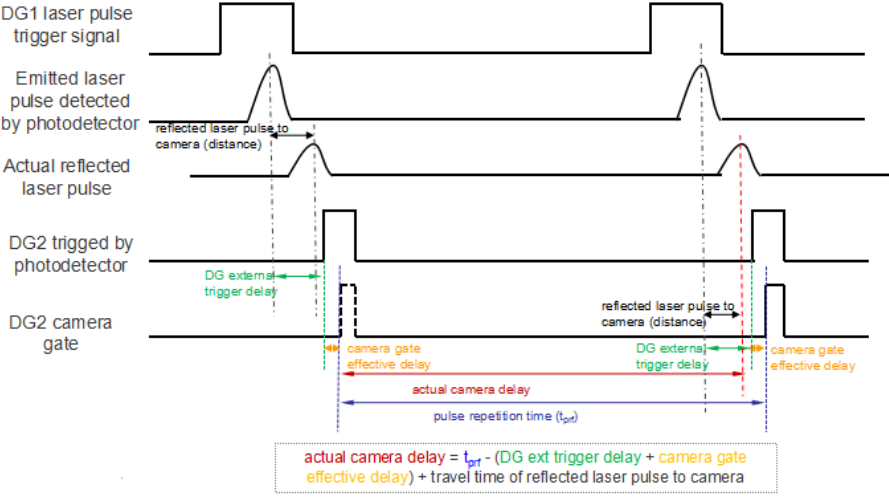
Figure 3. Timing diagram of the synchronization control.